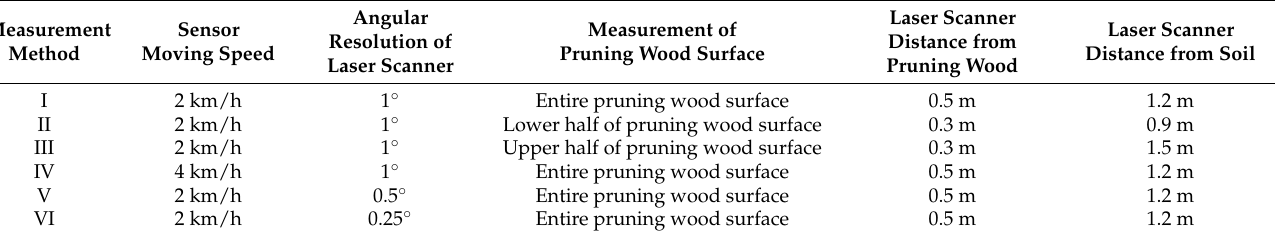
Figure 2. Field measurement with the LMS 200 laser scanner with a vineyard tractor. Table 1. Measurement methods settings for the laser scanner sensor used.